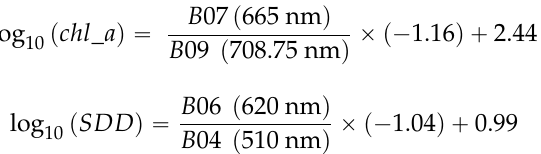
Figure 5. Scatter plots between selected MERIS atmospherically corrected reflectance ratio and in situ chl-a ( a ) and between selected MERIS atmospherically corrected reflectance ratio and in situ SDD ( b ). The LME models were developed from the relationships between selected band ratios and the logarithmic scale of chl-a and SDD. The month of in situ data collection represented the random effect due to repeated measurements in time. Random slopes and intercepts were considered for each group of measurements in a single month. Goodness of fit (r-squared; R 2 ) for the outermost and innermost levels of prediction was 0.49 and 0.56 for chl-a and 0.78 and 0.83 for SDD, respectively. Therefore,